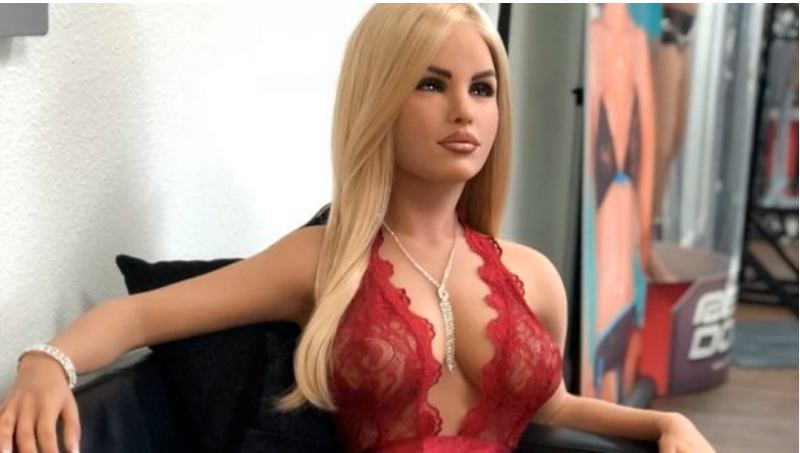
Figure 1. Harmony, marketed as “the perfect companion” with artificial intelligence (Source: http://www.sickchirpse.com/biggest-worry-men-sex-robots/).